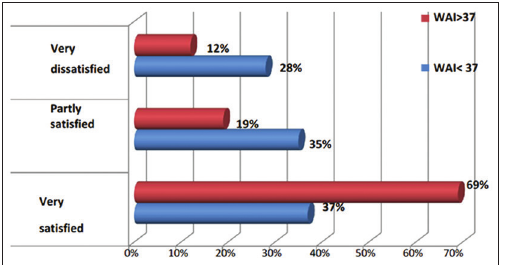
FIGURE 5. Work ability and satisfaction level in relation to situation at work and profession. Of the total number (199) of employees with good work ability, 137 (69%) of them was very satisfied with situation at work and their professions.